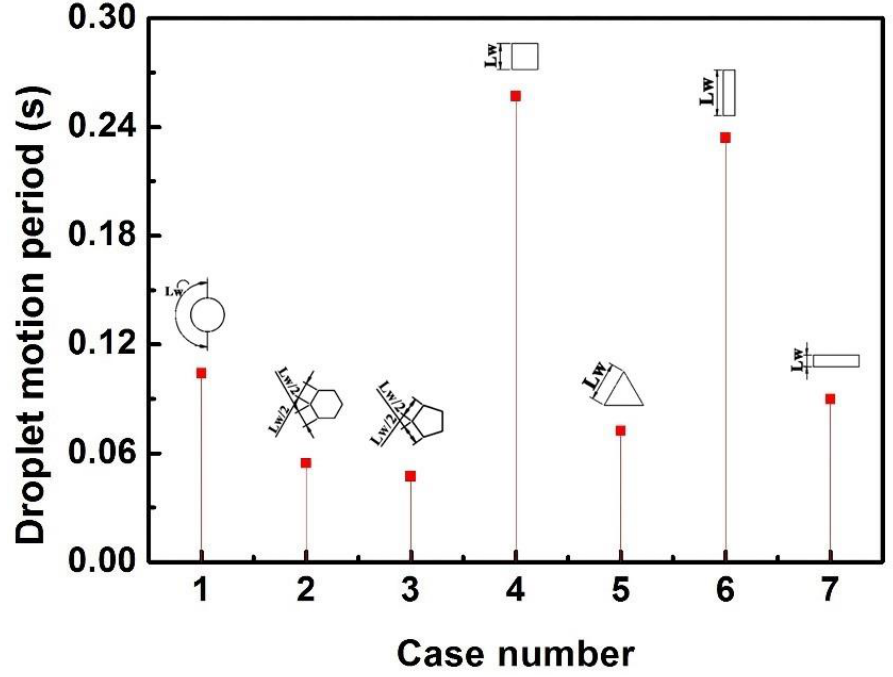
Figure 4. Effect of the pore shape on the droplet movement cycle.